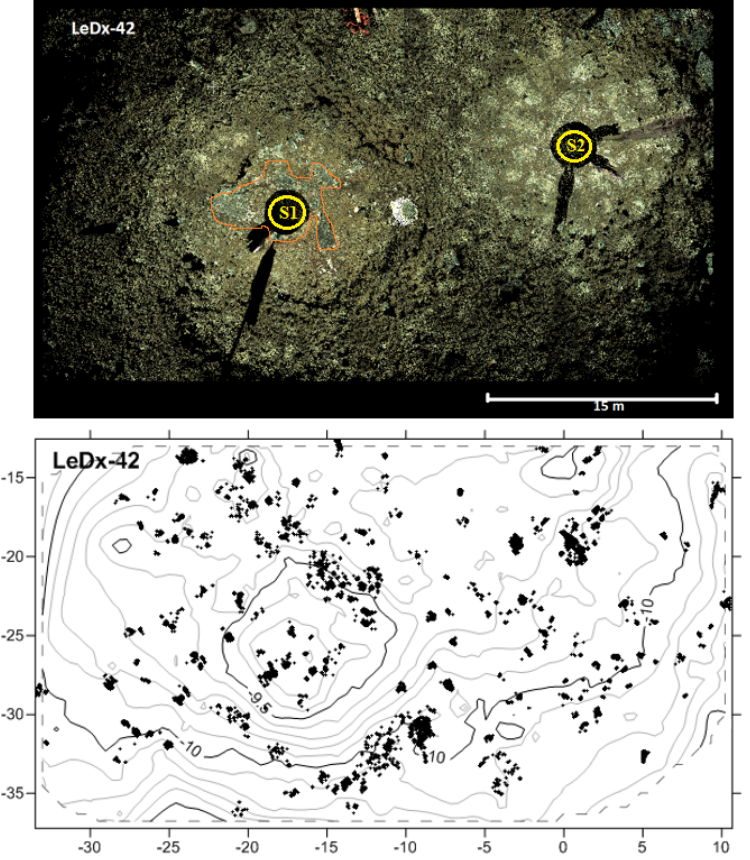
Figure 5: Top: Original point cloud sample from LeDx-42. Gaps in the data represent the location of the laser scanner stations and are indicated by S1 and S2. The exposed stone outcrops on the surface are also outlined in orange. Bottom: Extracted stone boulders from point cloud and layered on top of surface contour map. Stone clusters are found radiating from the points of highest elevation near the left side of the map, away from the hummocky tundra seen on the right. Scale is in